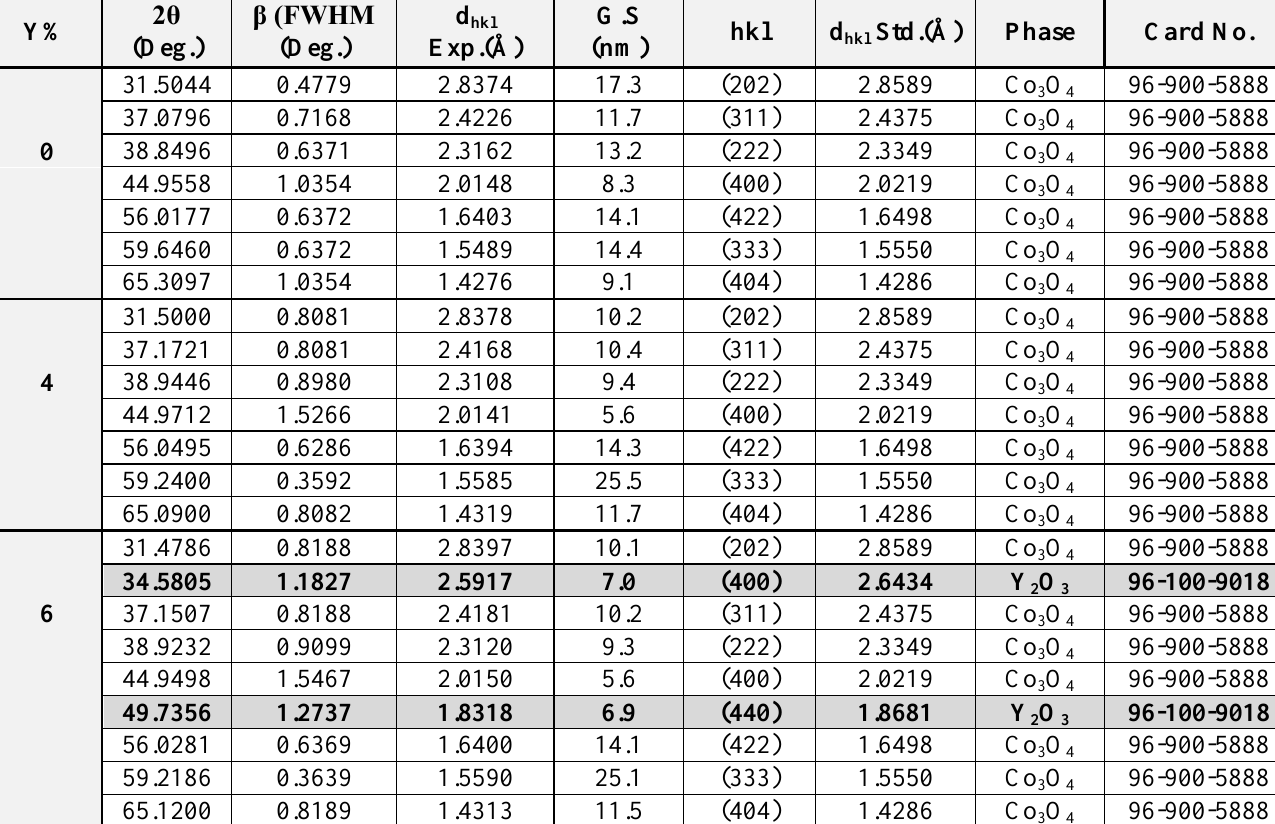
O and cobalt yttrium oxide. 3 4